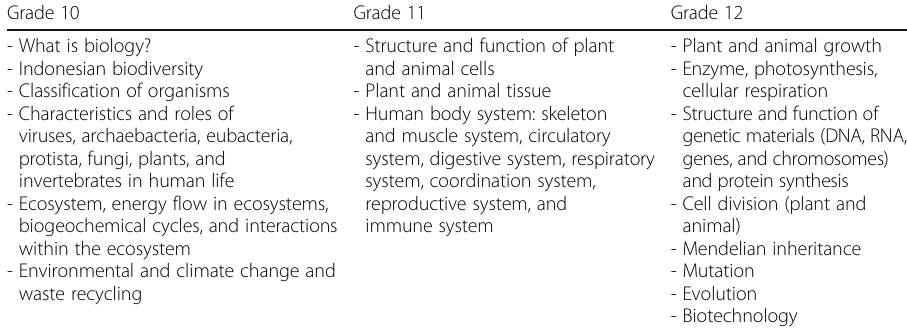
Table 4 Biology topics for senior secondary school level Grade